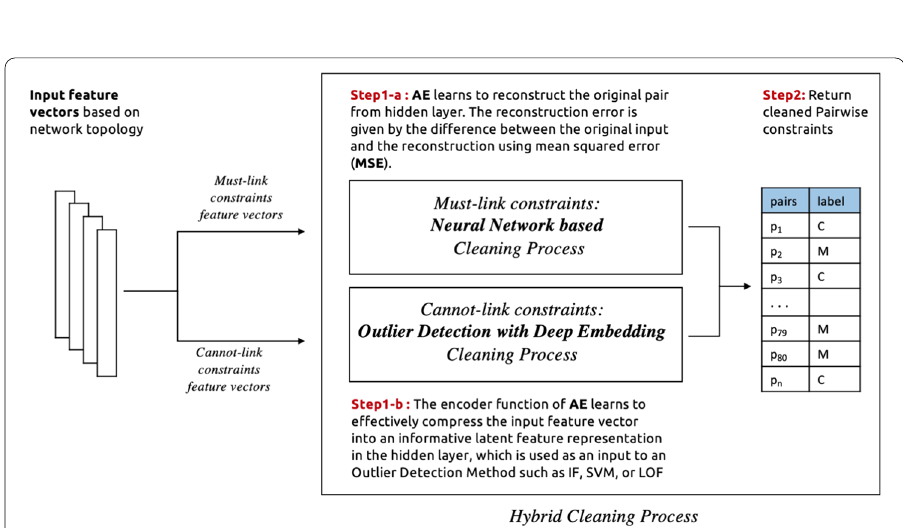
Fig. 6 An illustration of the process for identifying noisy pairwise constraints using hybrid cleaning process. A combination of traditional models, and deep learning based outlier detection